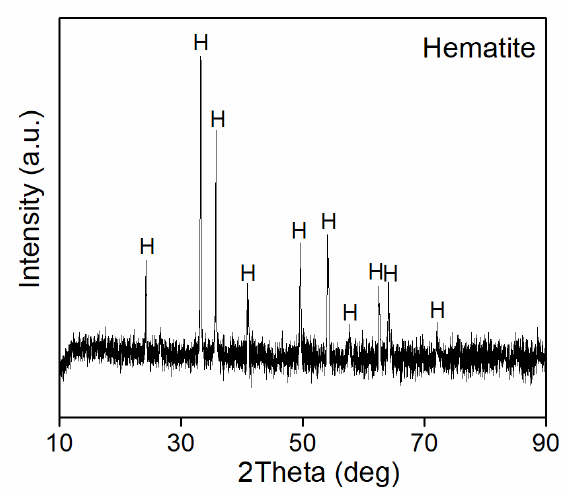
Figure A4. XRD result for hematite PA. Hematite (H) was identified.